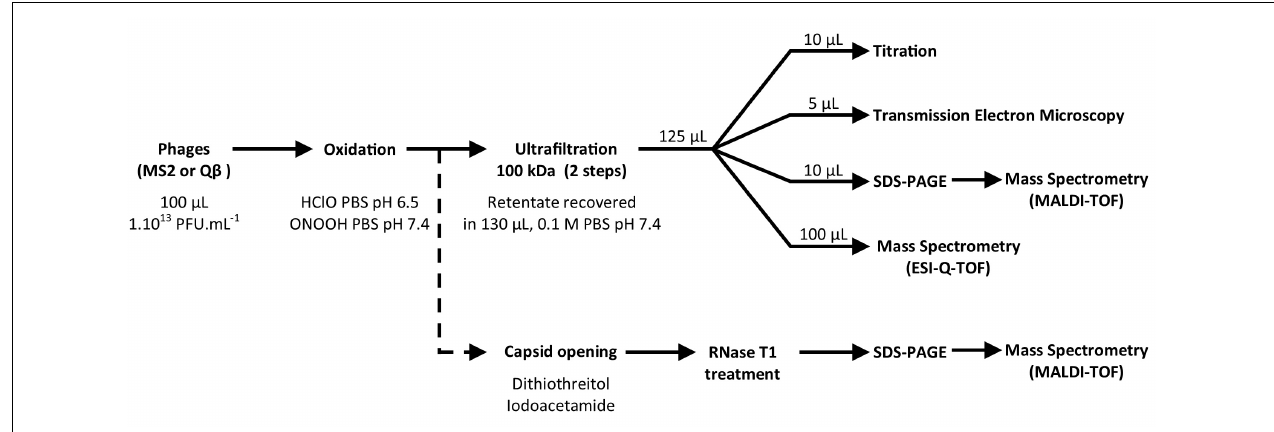
FIGURE 1 | Experimental strategies to define the capsid modifications corresponding to viral inactivation by HClO and ONOOH.